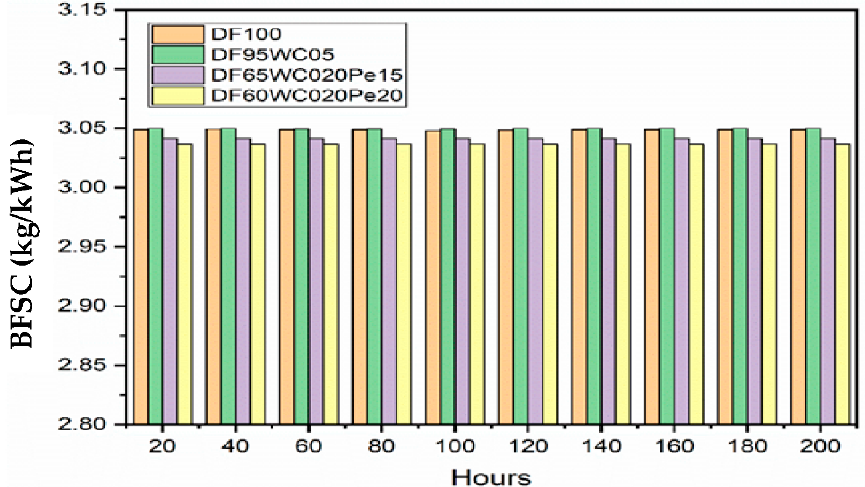
Figure 3. Comparison of BSFC for all test fuels.